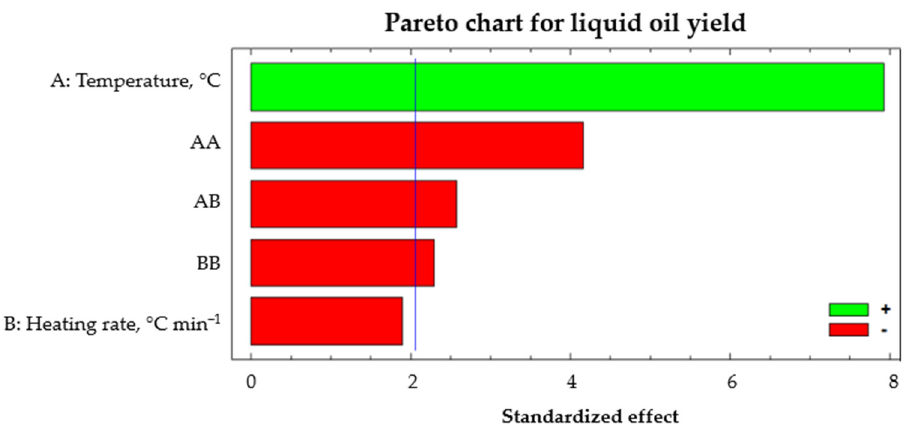
Figure 6. Standardized Pareto diagram for liquid oil yield.